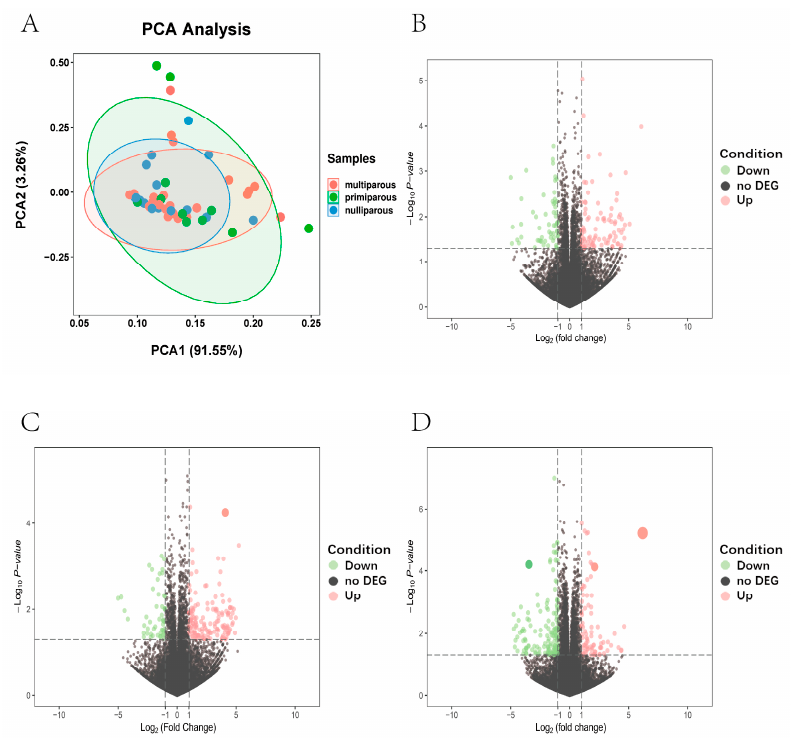
Figure 2. ( A ) PCA of the identified genes, the red, green, and blue dots represent samples of multiparous, primiparous, and nulliparous periods. ( B ) Volcano plot of differential genes, volcano plot for DEGs in the nulliparous period compared with the primiparous period. ( C ) Volcano plot for DEGs in the primiparous period compared with the multiparous period. ( D ) Volcano plot for DEGs in the nulliparous period compared with the multiparous period, red and green dots represent up/down-regulated DEGs, respectively. The gray dots represent not DEGs.